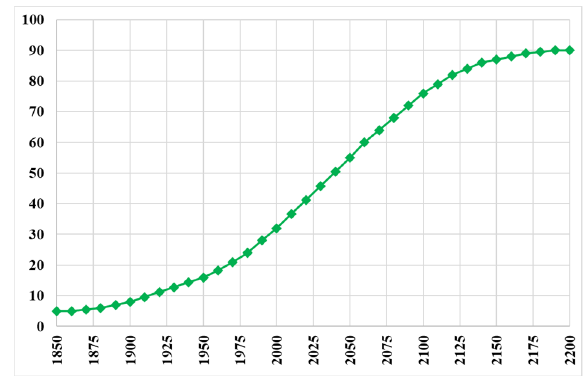
Figure 17. Energy use coefficient (percentage).